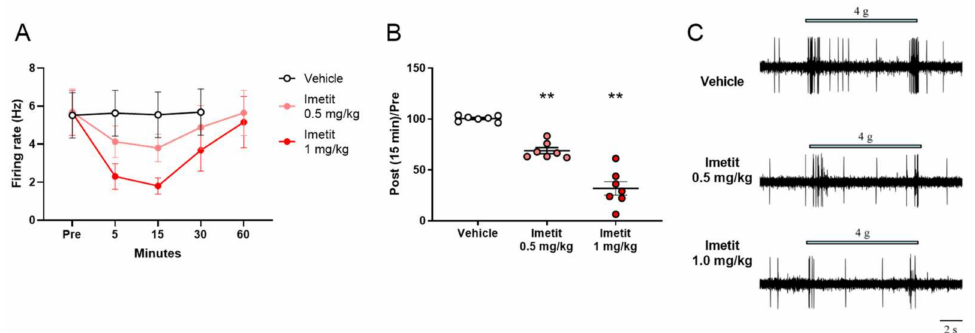
Figure 5. Dose-dependent effects of imetit on mechanical stimuli-evoked firing of the spinal dorsal horn: ( A ) temporal changes in the firing rate, ( B ) post and pre-administration ratios, and ( C ) rep- resentative trace of vFF-evoked firing recorded 15 min following administration in the vehicle and imetit groups. Data are presented as the mean ± S.E.M. ** p < 0.01 vs. vehicle group analyzed using Dunnett’s multiple comparison test (n = 7).